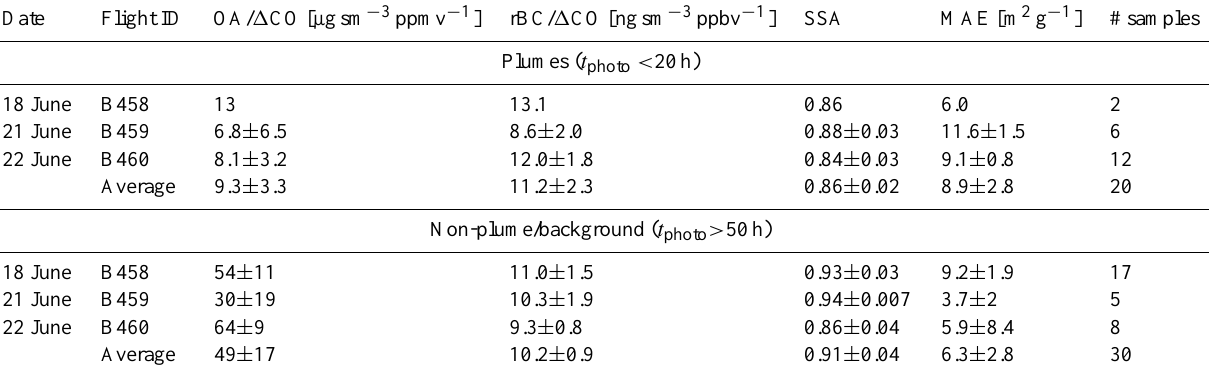
Table 4. Average OA/ 1 CO, rBC/ 1 CO, single scattering albedo (SSA) and mass absorption efficiency (MAE) for plume and non-plume periods determined from the photochemical age calculated from whole air canister toluene and benzene mixing ratios. Only flights with valid canister data are